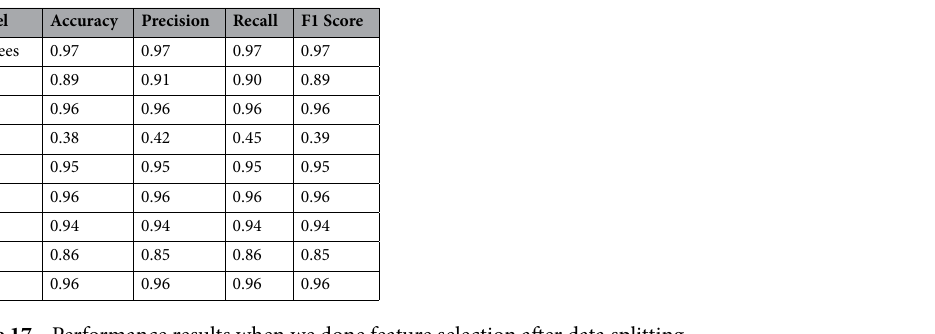
Table 17. Performance results when we done feature selection after data splitting.